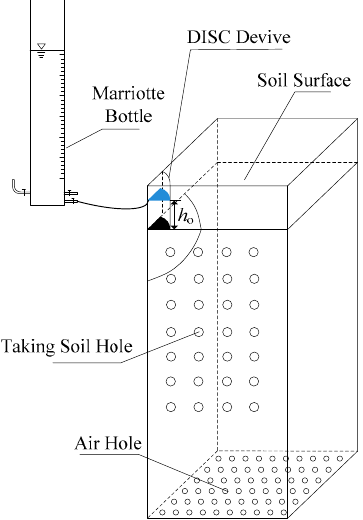
Figure 3. Simplified experimental setup ( h 0 is the irrigation depth) .